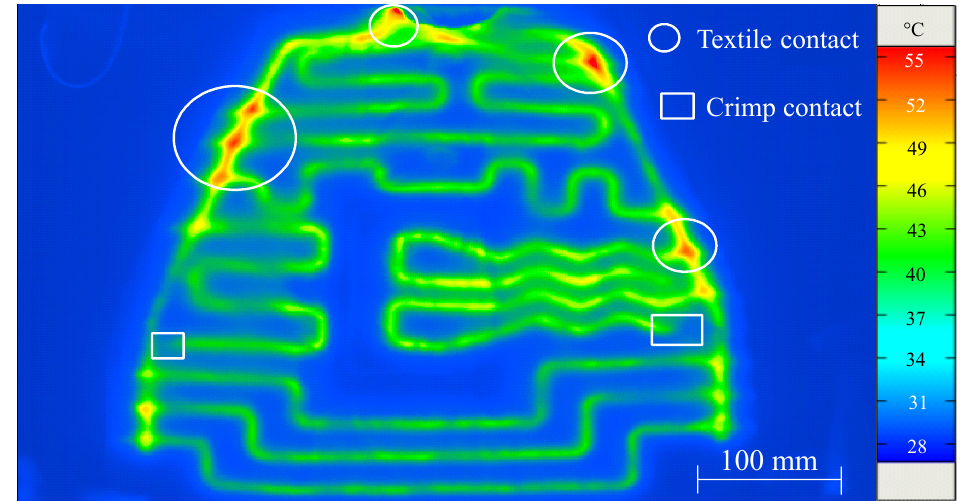
Figure 13. Thermogram of the contact layer surface in the operating state of the functional warming layer.